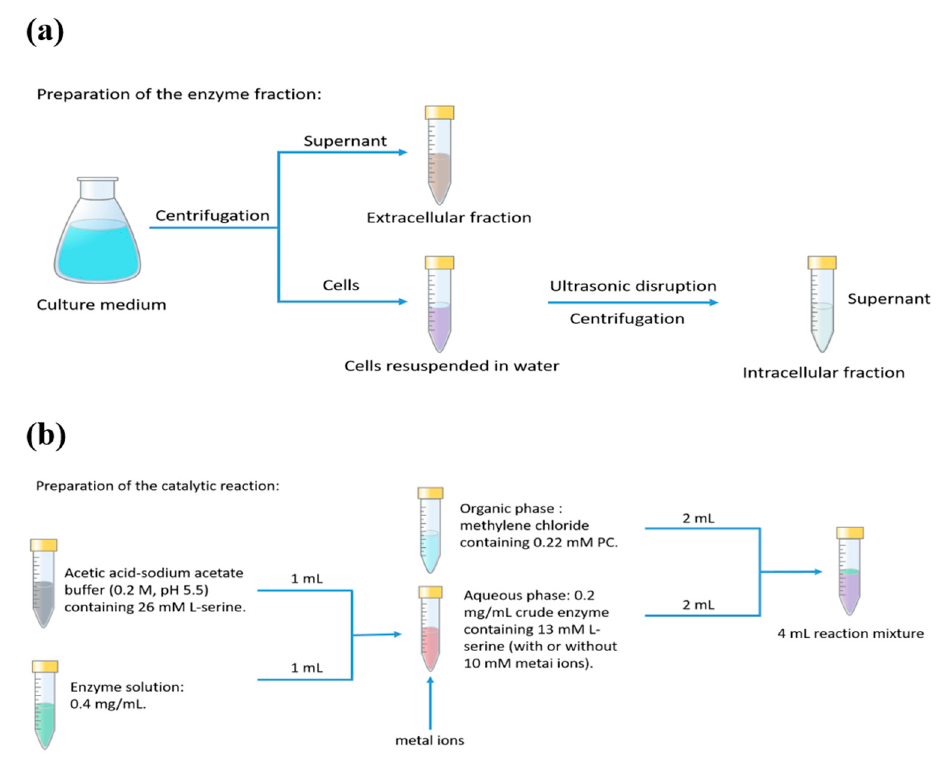
Figure 7. Flow charts of crude enzyme preparation and catalytic reaction. ( a ) Preparation of the crude enzyme. ( b ) Preparation of the catalytic reaction.